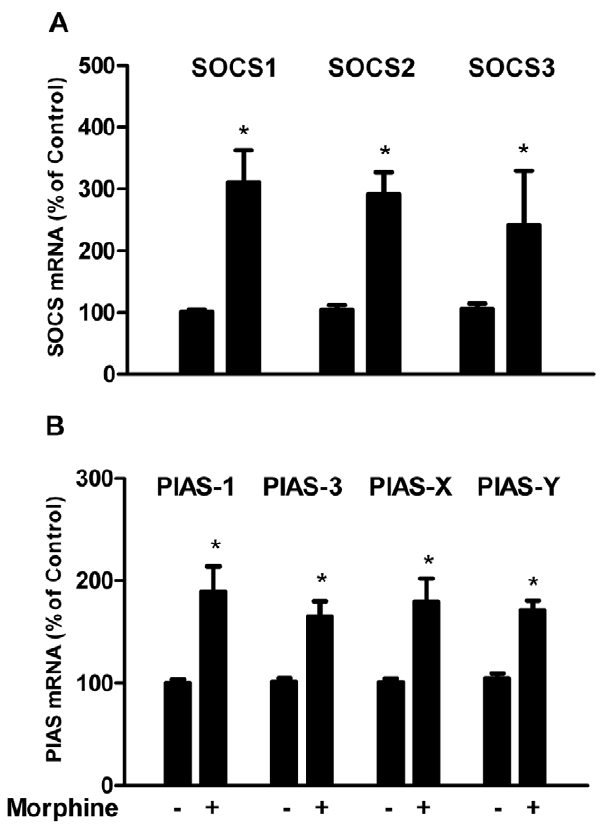
Figure 7. Effects of morphine on SOCS-1, 2, 3 (A), PIAS-1, 3, X and Y (B) expression. Seven-day-cultured macrophages were treated with or without morphine (10 2 10 M) for 3 h, and cellular RNA was subjected to the real-time RT-PCR for mRNA detection. Data are expressed as mRNA levels in morphine-treated cells (percentage of control) to those in untreated cells. The results represent the mean 6 SD of three independent experiments. Statistical analysis was per- formed by Student’s t-test and significance is shown with *P , 0.05 (morphine versus control).